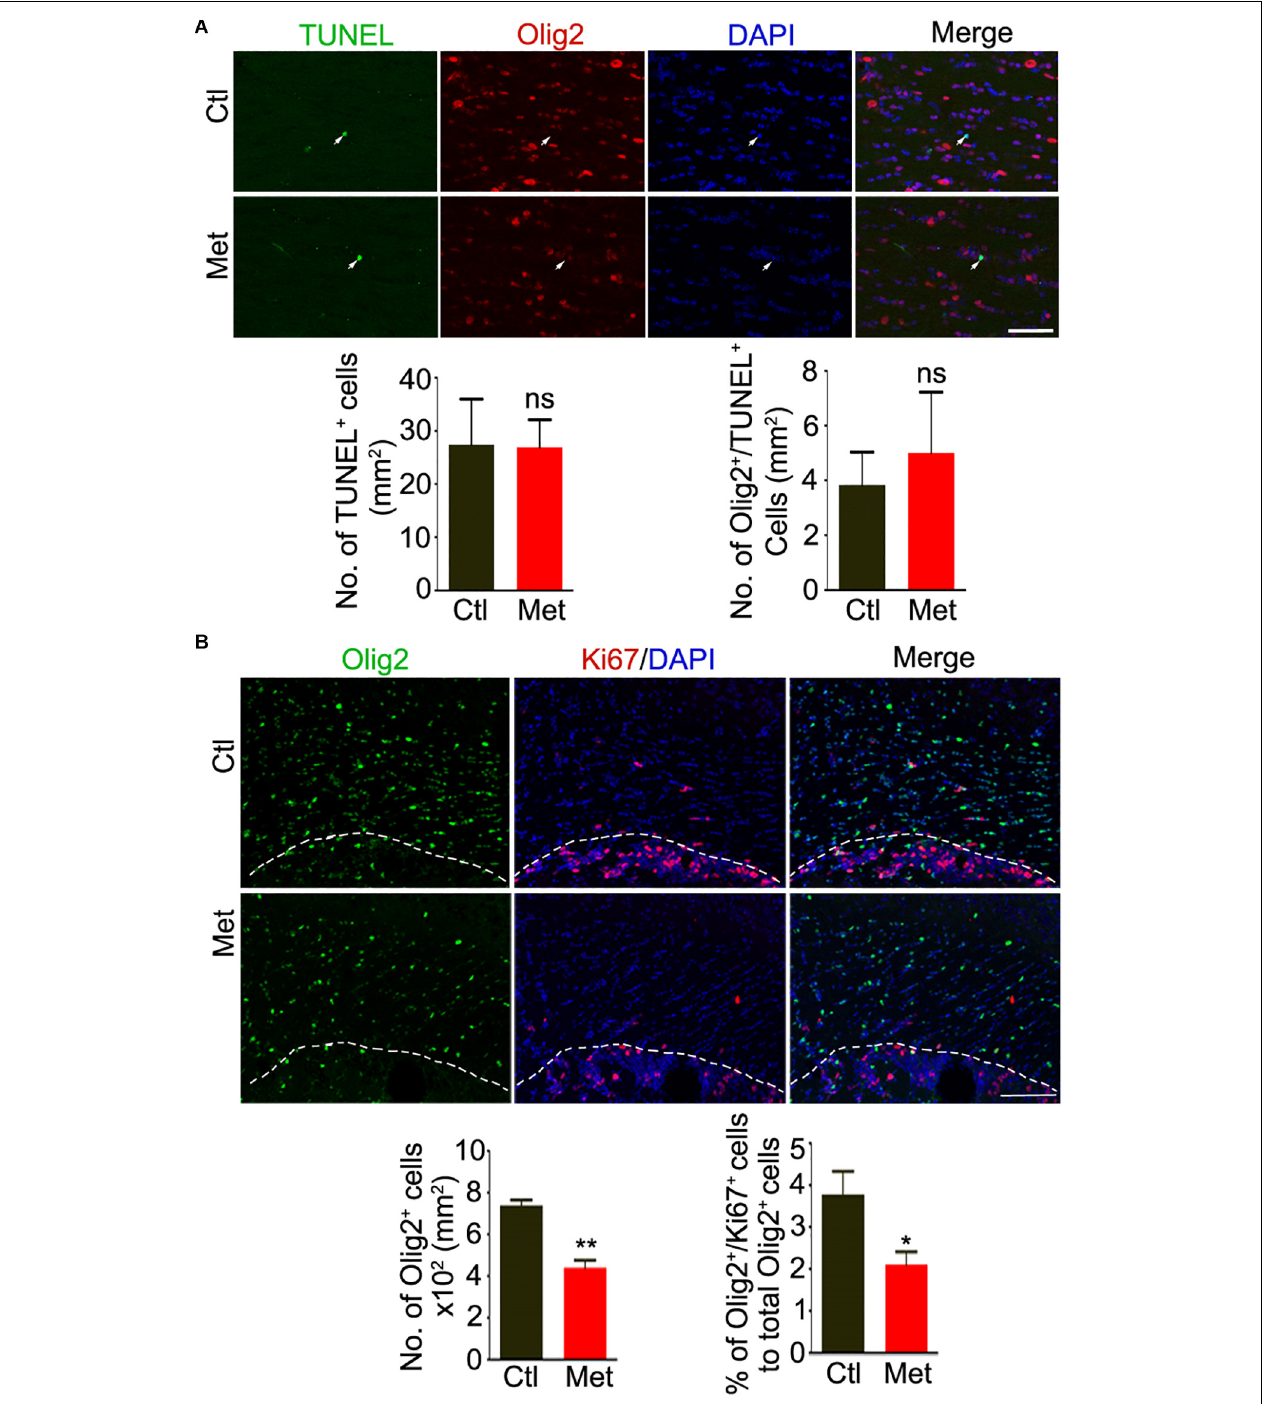
FIGURE 3 | Analysis of apoptosis and proliferation of oligodendroglial lineage cells after Met treatment. (A) Representative images showing immunofluorescence staining of TUNEL and Olig2 in the frontal white matter of mice. White arrows indicate representative TUNEL and Olig2 duoble-labling cells. The left bar graph shows the quantification of density of TUNEL positive cells ( n = 5 for each group). The right bar graph shows the density of Olig2/TUNEL double-labeling cells ( n = 5 for each group). (B) Representative images showing immunofluorescence staining of Ki67 and Olig2 in the frontal white matter of mice. The white dashed line indicates the edge of frontal white matter. The left bar graph shows the quantification of density of Olig2 positive cells ( n = 5 for each group). The right bar graph shows the percentage of Olig2/Ki67 double-labeling cells to Olig2 positive cells ( n = 5 for each group). Scale bars = 50 µ m. The data are expressed as the mean ± SEM. * P < 0.05; ** P < 0.01; ns, no significant